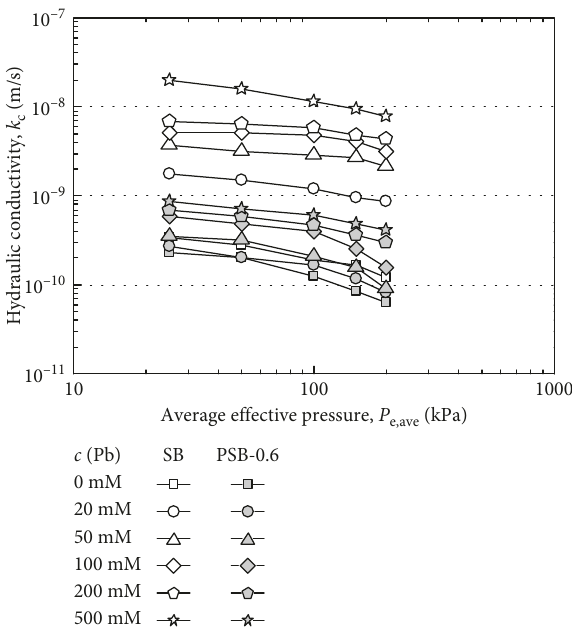
Figure 8: The relationship between hydraulic conductivity ( k backfills and the average effective pressure ( P e,ave ).